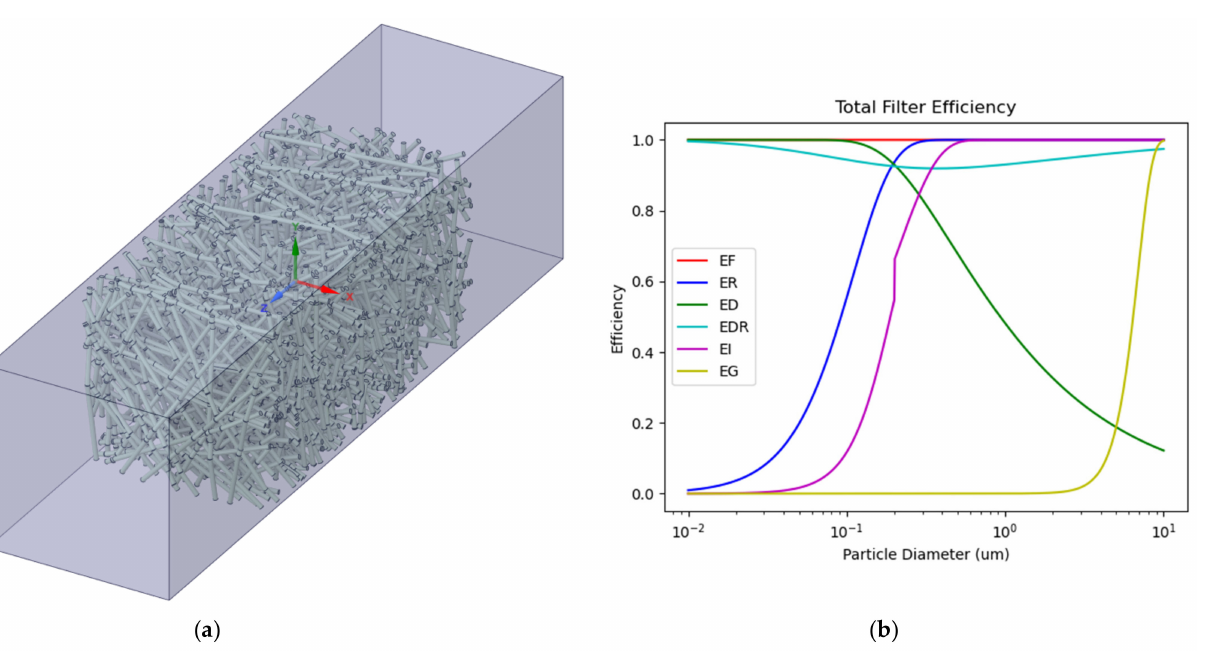
Figure 12. Digital twin HEPA filter built to 99.97% efficiency. ( a ) Geometry loaded into enclosure for CFD modeling. ( b ) Total filter efficiency shown by SFE model